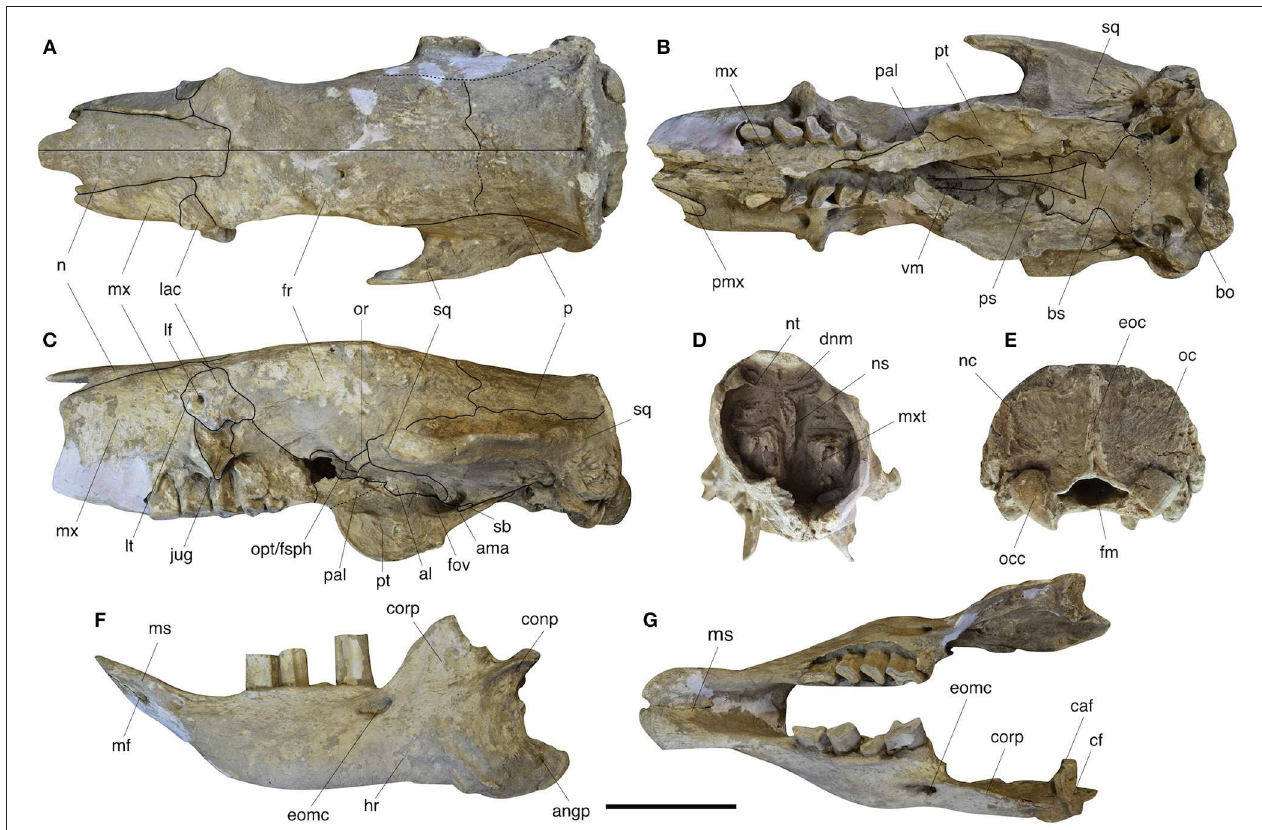
FIGURE 2 | Skull and mandible of Catonyx tarijensis MNHN-Bol V 13364 from the Pleistocene of Oruro (Bolivian Altiplano). Skull in dorsal (A) , ventral (B) , lateral (C) , anterior (D) , and posterior (E) views. Mandible in lateral (F) and occlusal (G) views. al, alisphenoid; ama, accessory mandibular articulation; angp, angular process; bo, basioccipital; bs, basisphenoid; caf, condylar accessory facet; cf, condylar facet; conp, condyloid process; corp, coronoid process; dnm, dorsal nasal meatus; eoc, external occipital crest; eomc, external opening of the mandibular canal; fm, foramen magnum; fov, foramen ovale; fr, frontal; hr, horizontal ramus of mandible; jug, jugal; lac, lacrimal; lf, lacrimal foramen; lt, lacrimal tubercle; mf, mental foramen; ms, mandibular spout; mx, maxilla; mxt, maxilloturbinate; n, nasal; nc, nuchal crest, ns, nasal septum; nt, nasoturbinate; oc, occipital; occ, occipital condyle; opt/fsph, common aperture for the optic foramen and sphenorbital fissure; or, orbitosphenoid; pal, palatine; p, parietal; pmx, premaxilla; ps, presphenoid; pt, pterygoid; sb, sutural bone; sq, squamosal; vm, vomer. Scale bar equals